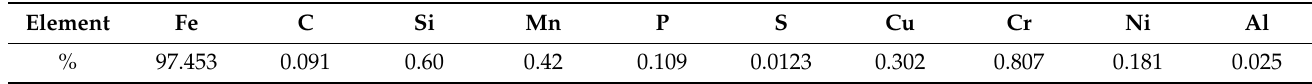
Table 1. Chemical composition in % of weathering steel used for experimental samples. Element Fe C Si Mn P S Cu Cr Ni Al % 97.453 0.091 0.60 0.42